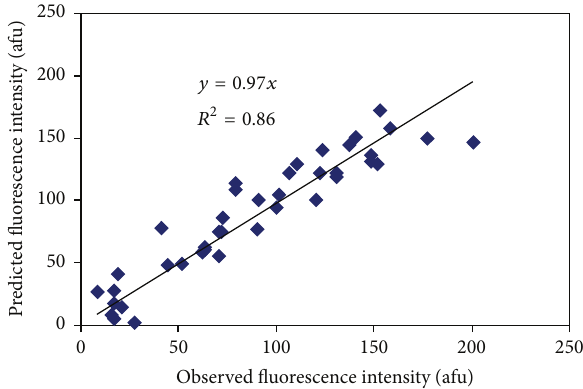
Figure 4: Fluorescence intensity predicted by the quadratic model versus fluorescence intensity observed in the experiments. Refer to Table 2 for experimental conditions and observed fluorescence intensity values. Refer to Table 3 for regression coefficients of the quadratic models. Fluorescence intensity was determined at excita- tion wavelength of 530 nm and emission wavelength of 607